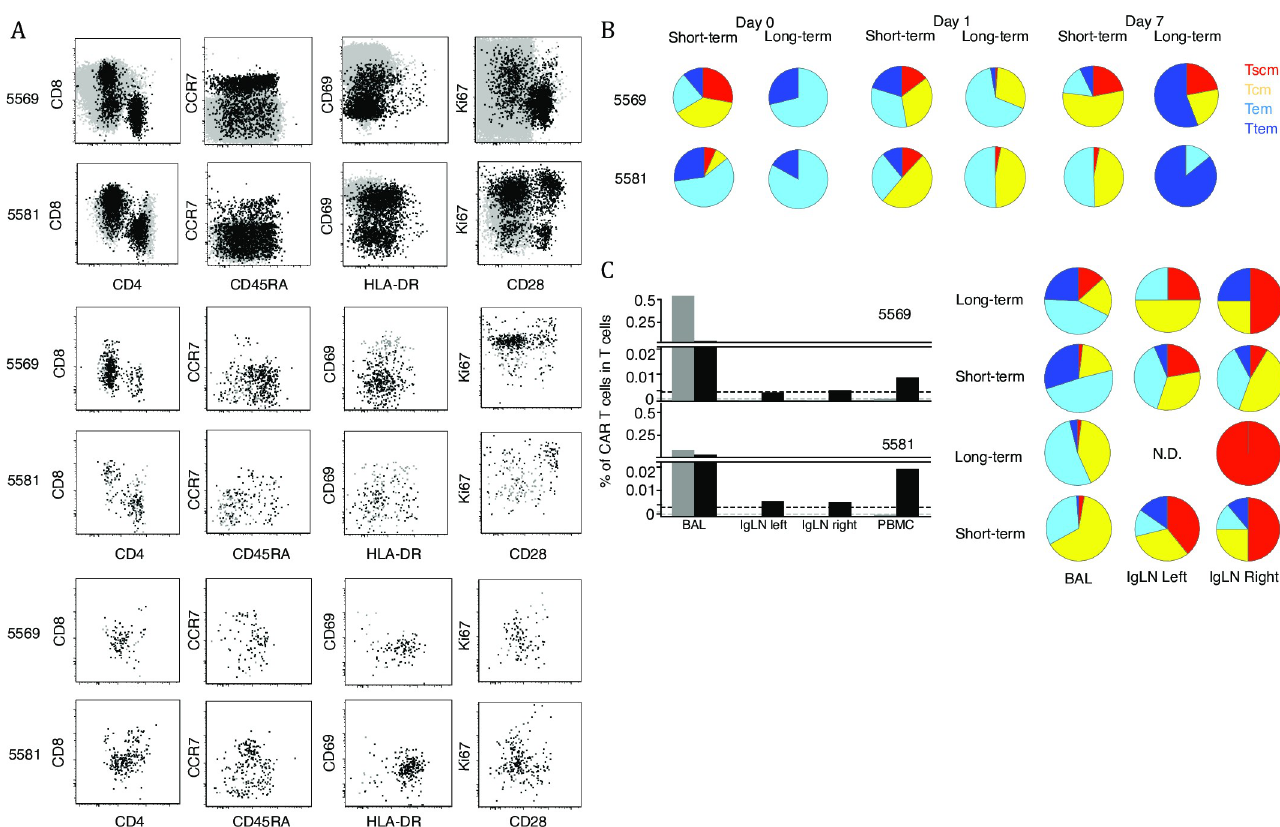
Fig 5. Comparison of CAR T cell expansion protocols in vivo. (A) Flow plot of anti-SIV-CAR T cells on the day of infusion and on 1 and 7 days after infusion. SIV-CAR T cells were gated based on reporter gene expression. CAR T cell phenotypes were analyzed by the expression of CD3, CD4, CD8, CD28, CD45RA, CD69, CD95 and CCR7. Ki67 was stained to check the in vivo proliferation of SIV-CAR T cells. (B) Anti-SIV-CAR T cell memory phenotypes SIV-CAR T cell memory phenotypes were classified based on CCR7 and CD45RA expression. (C)Tissue trafficking of anti-SIV-CAR T cells. Frequencies of anti-SIV-CAR T cells were measured on day 7 after infusion in BAL and inguinal lymph nodes. Grey bars show the percent of long-term expanded SIV-CAR T cells and black bars show the percent of short-term expanded anti-SIV-CAR T cells in CD3+ T cells. Pie charts show memory phenotypes of anti-SIV-CAR T cells in each tissue.